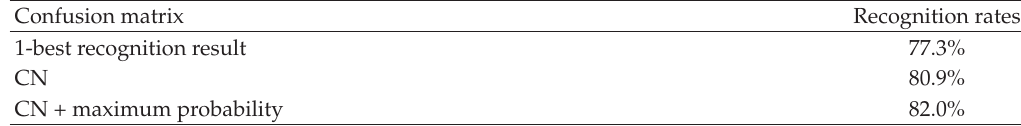
Table 2: Recognition rates of di ff erent phoneme confusion